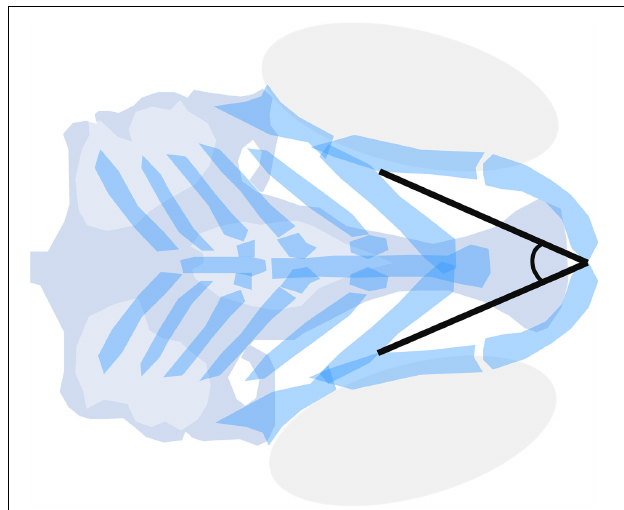
FIGURE 3 | Meckel’s-palatoquadrate (M-PQ) angle is proposed as a reliable high-throughput standard parameter to assess craniofacial outcomes after single or mixed compound exposures. The measurements can be easily obtained by imaging of cartilage stained larvae and proved to be informative on a broad spectrum of craniofacial malformations. The M-PQ angle is especially affected in craniofacial malformations such as microcephaly and